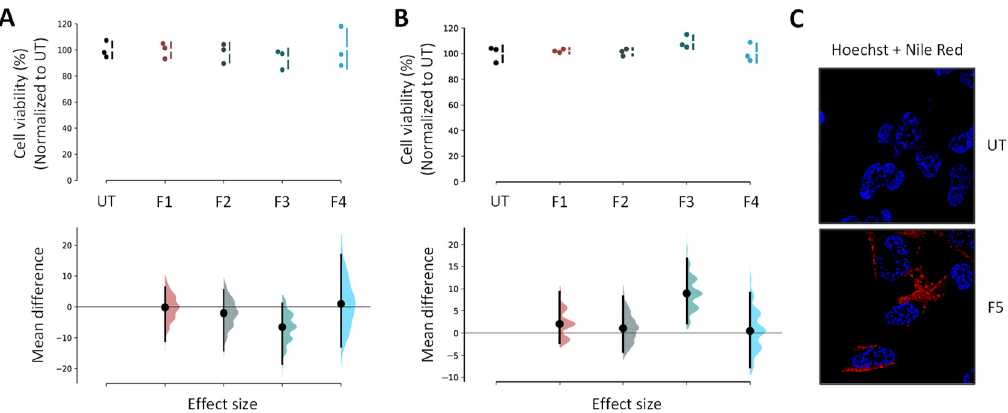
Figure 3. Biological evaluation of SLN and (un)loaded PLGA nanoparticles. ( A ) Cell viability evolution over time. BE(2)-M17 cells treated with F1 (red), F2 (dark blue), F3 (green), and F4 (cyan) compared to the untreated cells after ( A ) 24 h and ( B ) 48 h. n = 3. p < 0.05 compared with untreated cells. ( C ) Representative images of F5 internalization in BE(2)-M17 cells after 24 h of exposure (1/1000°). Nuclei were stained with Hoechst (blue) and F5 was highlighted by the presence of Nile Red (red). Scale bar: 10 µm.